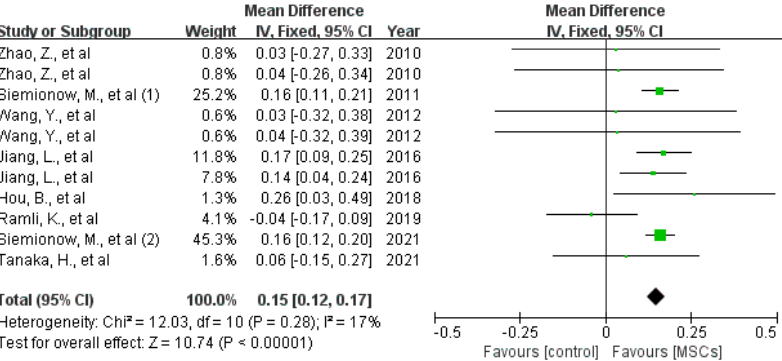
Figure 8. The forest plot shows the effect of MSCs on myelin thickness (middle and distal parts of the nerve defects) 12 weeks after surgery [5,11–36]. Plots on the left-hand side indicate favoring MSCs or MSCs-loaded scaffolds, while plots on the right side indicate favoring placebo-control treatment or blank scaffolds.